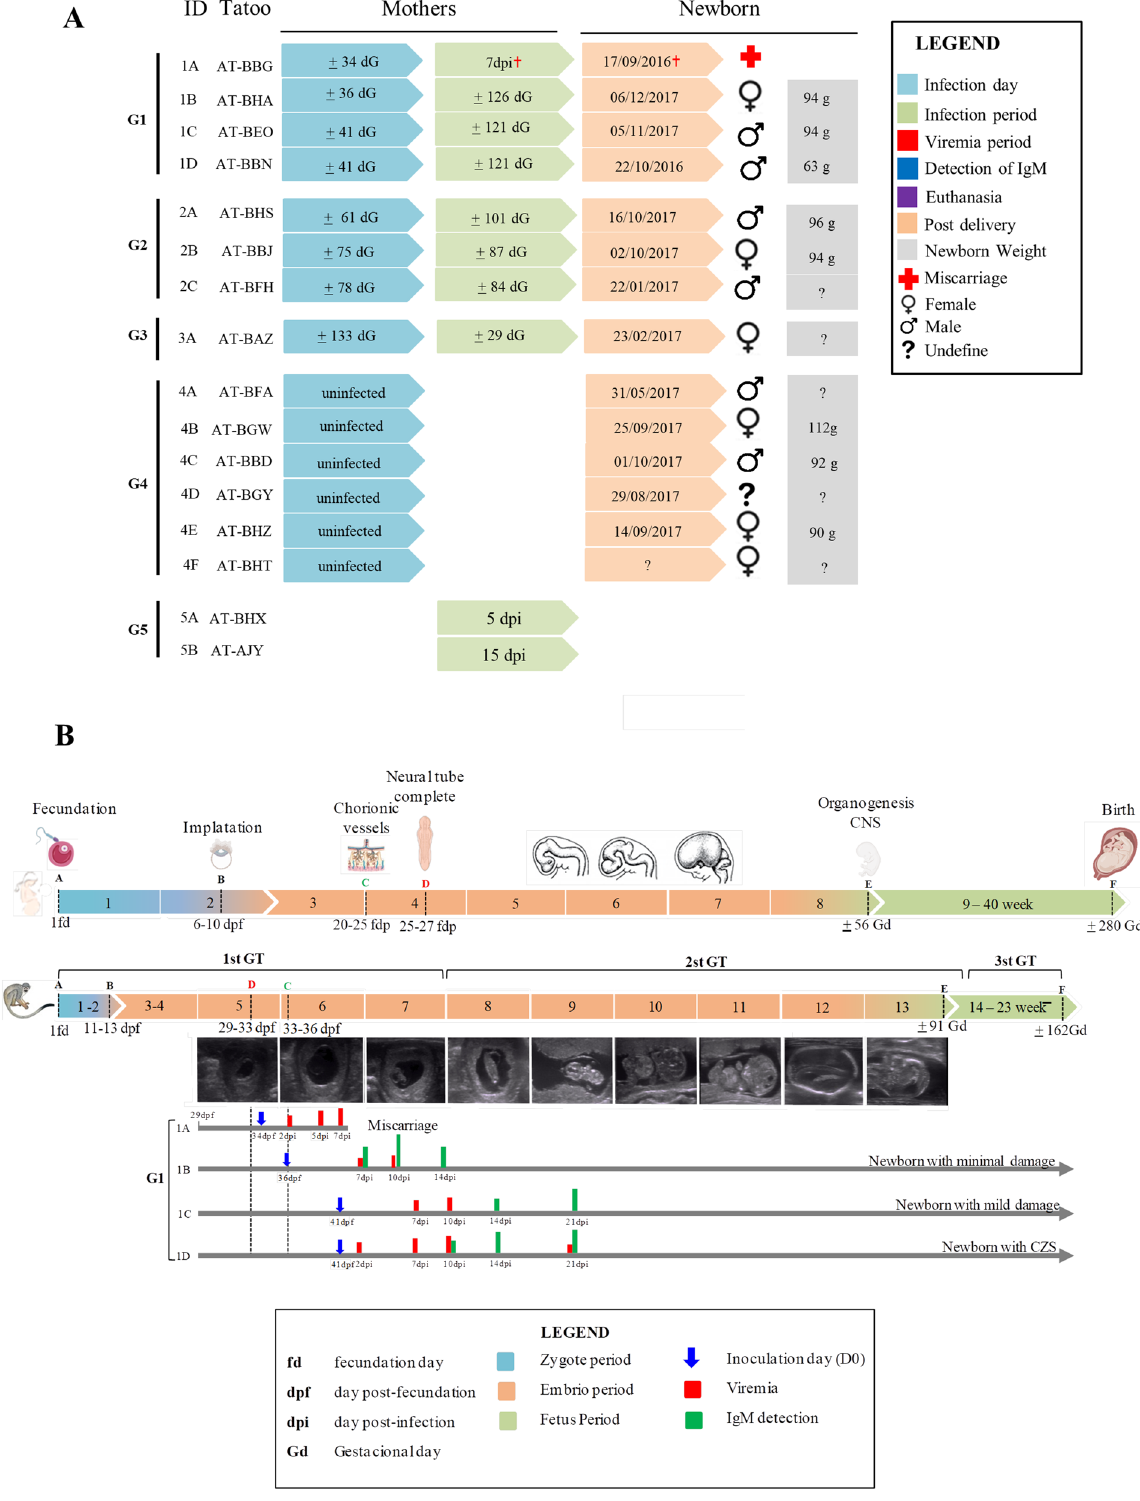
Figure 1. ( A ) Experimental information of squirrel monkeys (mothers and newborn) per group. ( B ) Comparison of squirrel monkey ( Saimiri collinsi ) gestational period with human gestational period from conception to birth and Time line showing embryo development from 5 to 13 Gestational weeks as well as incocultaion, viremia and IgM detection in females of Group